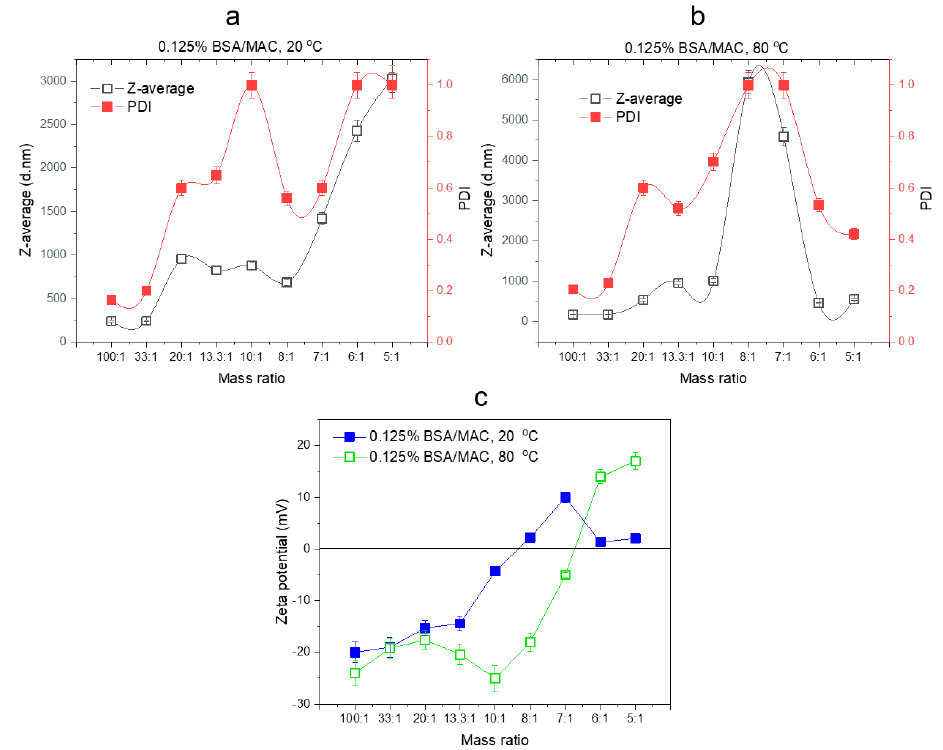
Figure 5. DLS ( a , b ) and zeta potential ( c ) results of nanogels synthesized with different weight ratios of BSA/MAC (0.125% w/v ).